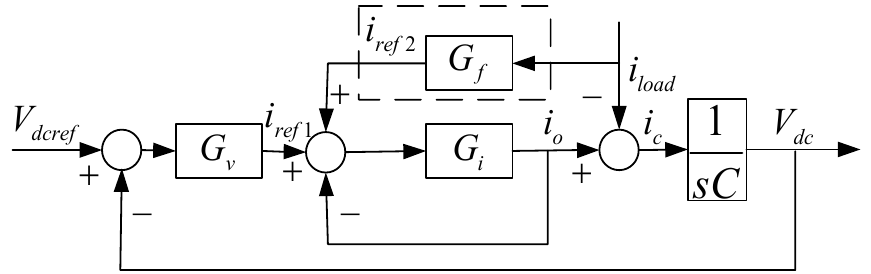
Figure 11. Double closed-loop control block diagram based on current feedforward.